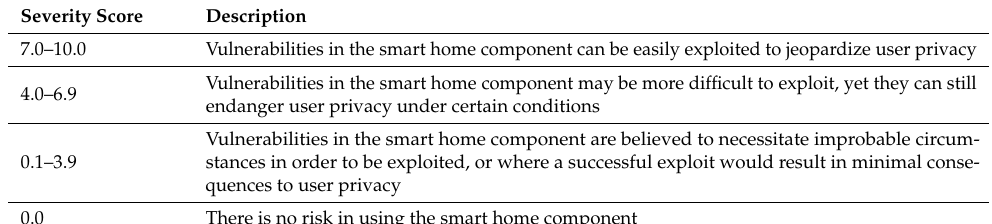
Table 7. Smart home component severity rating score ( r µ